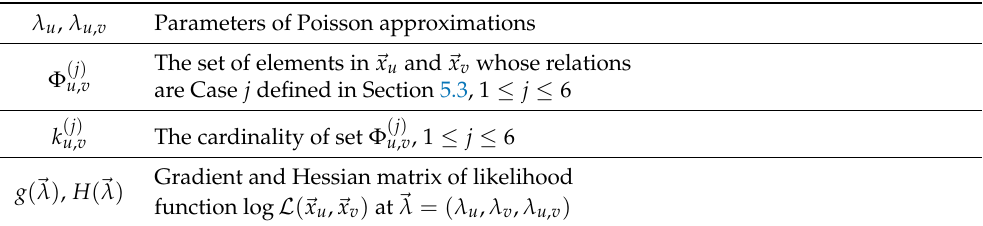
Gradient and Hessian matrix of likelihood function log L ( (cid:126) x u , (cid:126) x v ) at (cid:126) λ = ( λ u , λ v , λ u , v